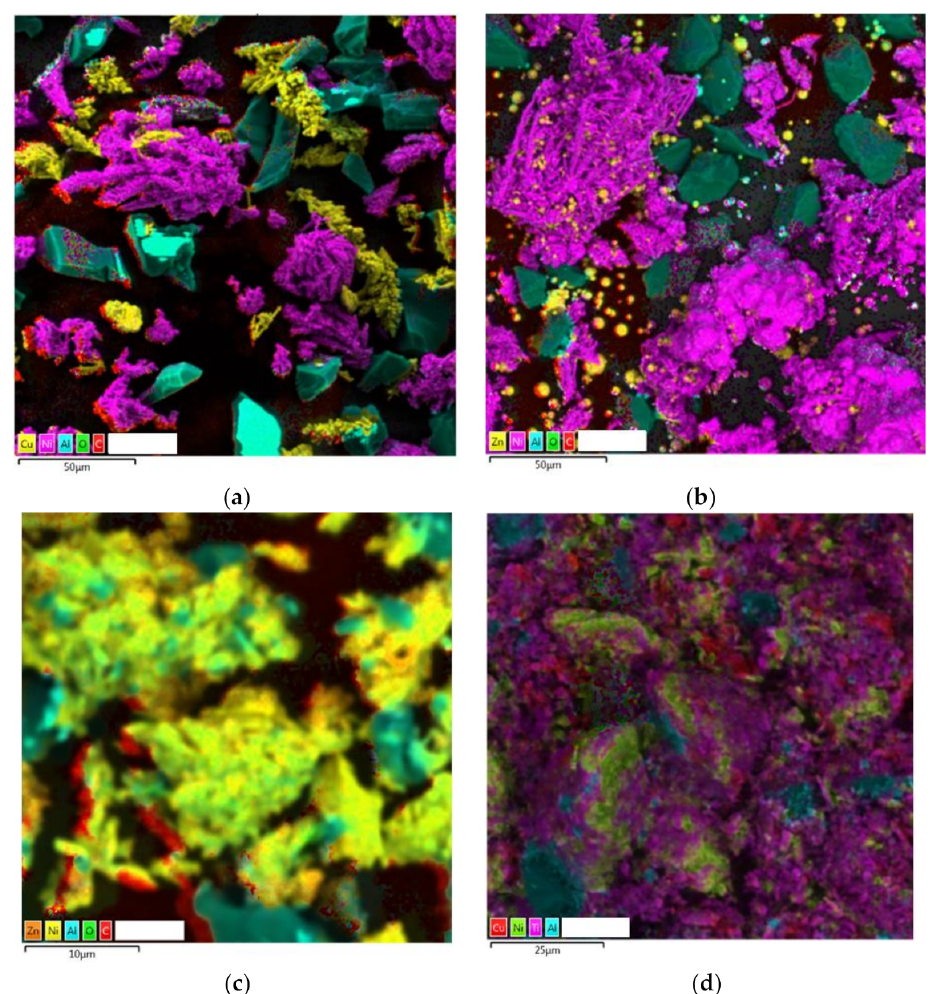
Figure 5. The EDS map of the distribution of elements of mechanical mixtures ( a ) Ni60-Cu40 and ( b ) Ni60-Zn40; and mechanically alloyed powders ( c ) Ni60-Zn40 (MA) and ( d ) (Ni50-Cu50)60-TiC40